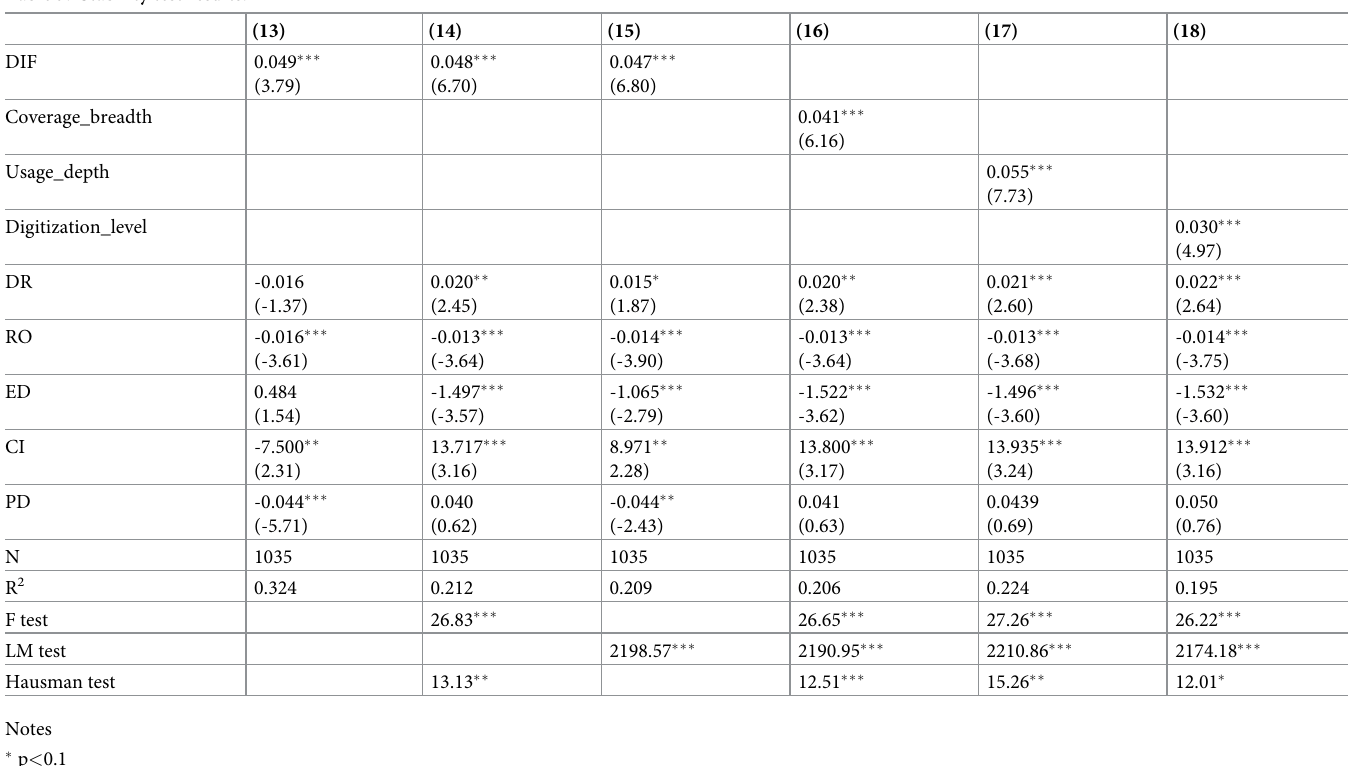
Table 5. Stability test